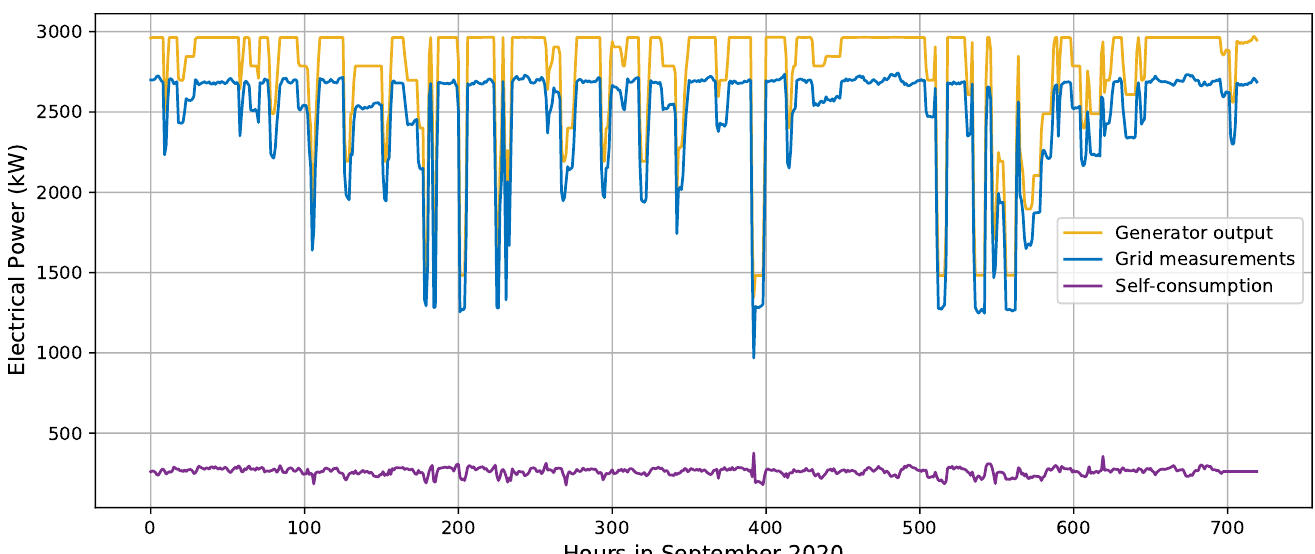
Figure 3. Electricity production of the generators (yellow), interpolated grid measurements (blue) and derived self- consumption of the biogas plant (purple) for September